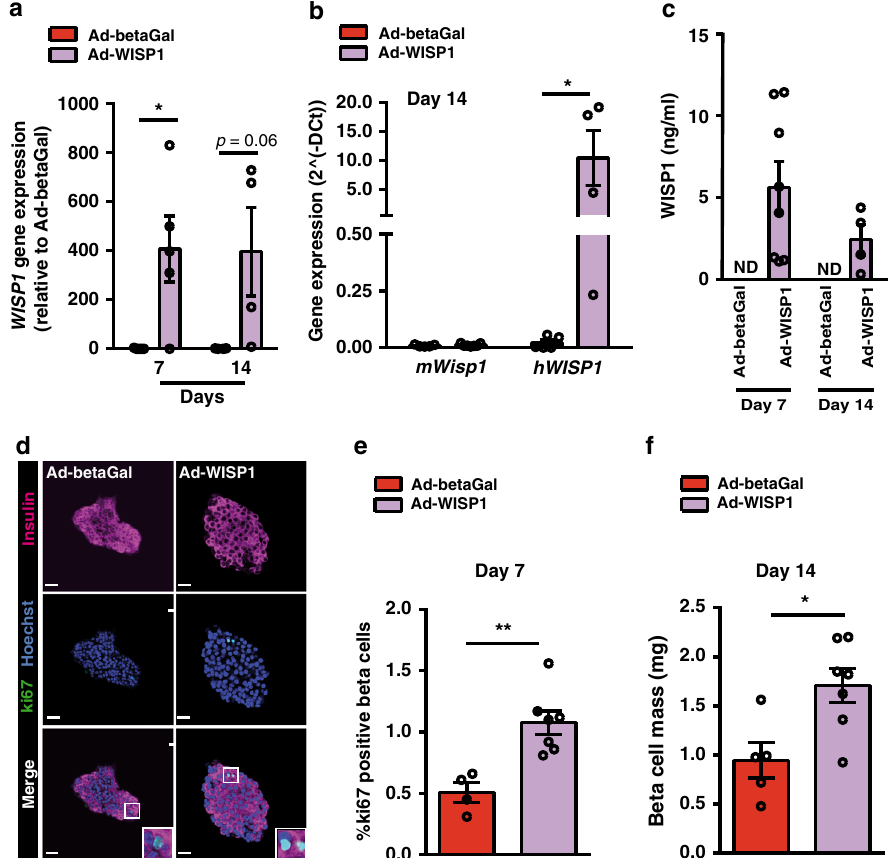
Fig. 4 Adenovirus-mediated expression of Wisp1 enhances endogenous beta cell proliferation in adult mice. Adenoviruses encoding human WISP1 (Ad- WISP1) or beta-galactosidase (Ad-betaGal) were injected via the tail vein into 12wo C57BL6/J mice. a Quanti fi cation by qPCR of human WISP1 transcripts in the livers of mice seven days and fourteen days ( n = 4) post-injection. Levels are expressed relative to values in mice injected with Ad-betaGal, given the value of 1. b Quanti fi cation by qPCR of mouse Wisp1 mRNA ( n = 5 for Ad-betaGal, red; n = 7 for Ad-WISP1, purple) and human WISP1 transcripts ( n = 5 for Ad-betaGal, red; n = 4 for Ad-WISP1, purple) in the livers of mice fourteen days post-injection. Expression levels are expressed relative to Tbp . c Serum human WISP1 levels were measured by ELISA at days 7 and 14 post-injection of Ad-betaGal ( n = 7) or Ad-WISP1 ( n = 8 at day 7; n = 4 at day 14, purple). Human WISP1 was not detectable (ND) in serum from mice injected with Ad-betaGal. d , e Beta cell proliferation following injection of Ad-WISP1 and Ad- betaGal. d Representative images of in toto immuno fl uorescence staining against ki67 (green) and insulin (purple) in islets isolated at day 7 after injection of the indicated adenoviruses. Nuclei are labeled with Hoechst (blue). e Percentage of beta cells (insulin + ) that are ki67 + at day 7 after injection of Ad- betaGal ( n = 4, red) or Ad-WISP1 ( n = 7, purple). f Beta cell mass at day 14 following injection of Ad-betaGal ( n = 5, red) or Ad-WISP1 ( n = 7, purple). All data shown represent mean ± SEM for the indicated n . * p < 0.05; ** p < 0.01 using two-tailed Student ’ s t test ( b , e , f ) or two-way ANOVA ( a , c ). Scale bars are 25 μ